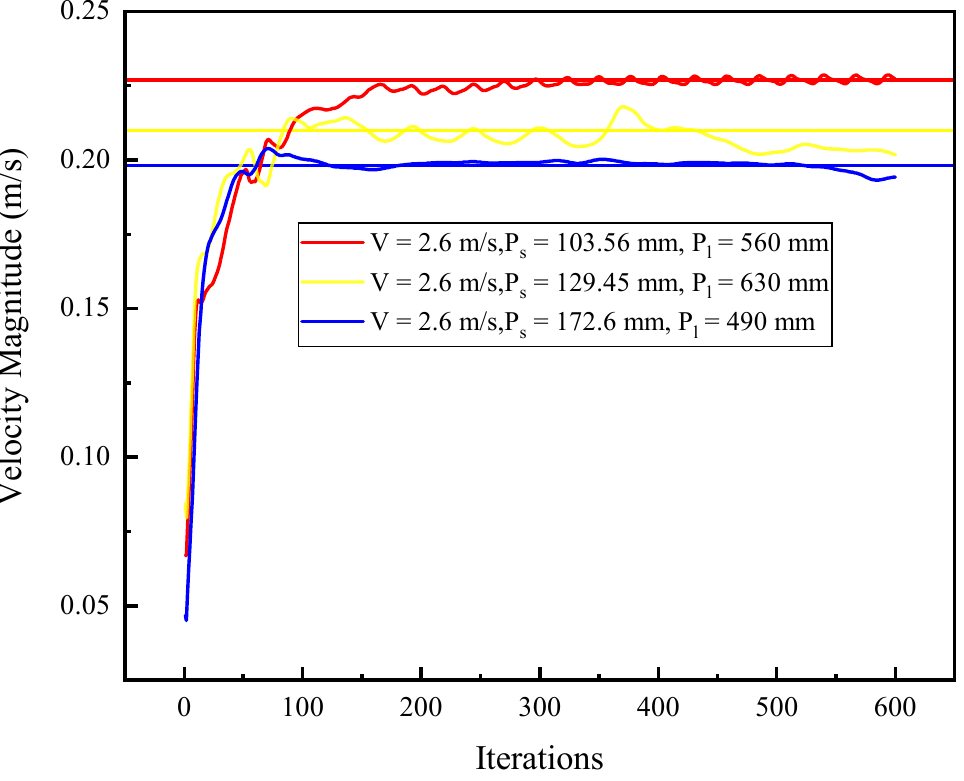
Figure 5. Variations in speed with the number of iteration steps for each working condition.